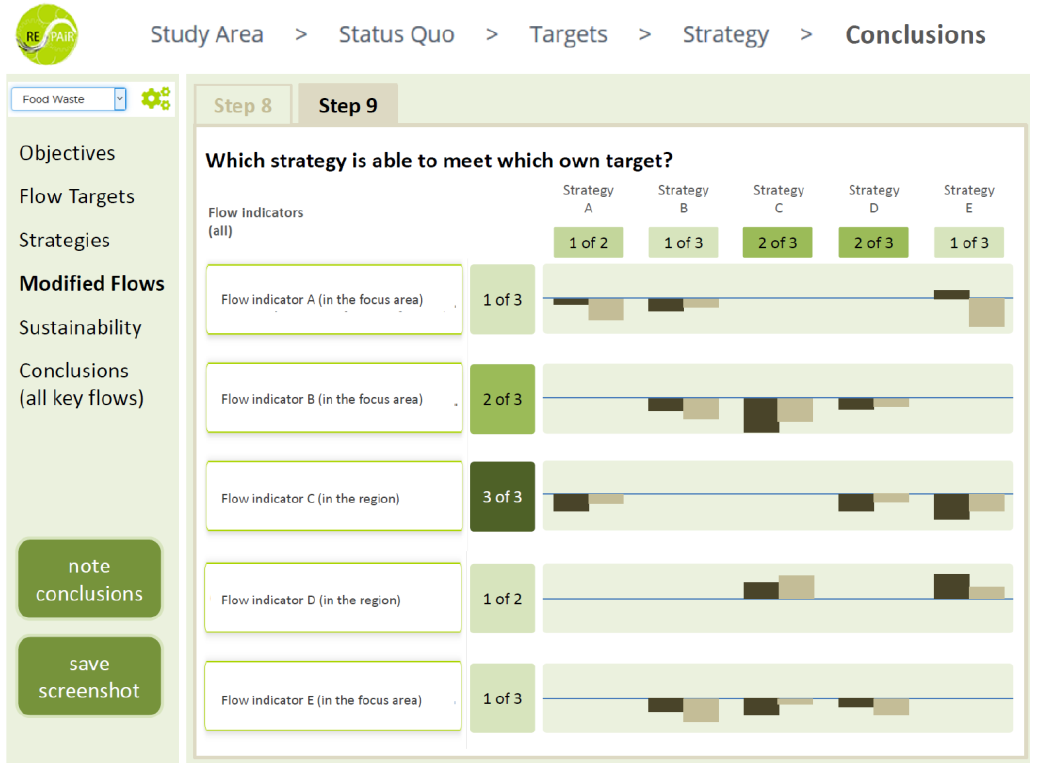
Figure 16. The GDSE comparing impacts of strategies (A, B, C, D, E) in terms of flow assessment targets. A green color ramp is used to indicate the fraction of targets met, where dark green indicates a big fraction and light green for a small fraction. decision-making on strategies for a given territory with close stakeholder involvement. In addition, the GDSE in- tegrates spatial data on material flows and related actors, which are presented in a visual and accessible way and ensures a sound and accessible evidence base in the par- ticipatory